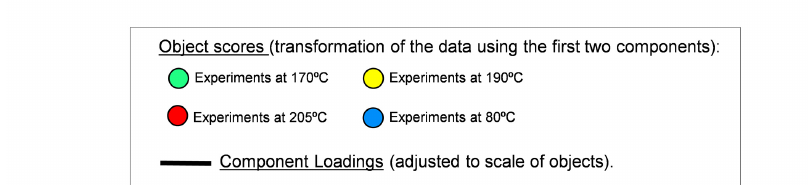
Figure 5. CATPCA biplot using the experimental synthesis conditions used, reaction time, conversion degree values, elemental composition and calculated EOR data (%) from the FTIR spectra for the NH 4 CN-derived polymers obtained as variables. Component loadings of variables are indicated by vectors and object scores of experiments by dots. In this analysis, each experimental series was analyzed independently: ( a ) 80 °C series; ( b ) 170 °C series; ( c ) 190 °C series; and ( d ) 205 °C series. The reaction time for each synthesis is indicated in Table S1. The ellipses surround the most related experimental results.